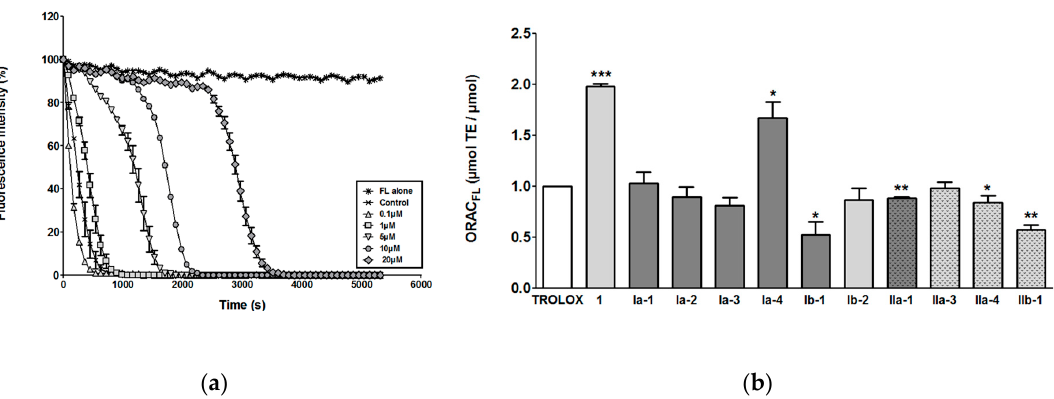
Figure 3. ( a ) Fluorescein (FL) fluorescence decay curve induced by AAPH. Tested compounds (0.1–20 µ M) or trolox standard (1–50 µ M) were pre-incubated with FL (12 nM) in D-PBS (pH 7.4) at 37 °C for at least 30 min. The addition of AAPH reagent (30 mM) led to FL disappearance and the remaining FL fluorescence ( λ Ex : 485 nm; λ Em : 520 nm) was measured every 90 s for 60 cycles. Represented data show results obtained in the absence (control) or the presence of compound IIa-3 at different concentrations and are expressed as means ± SEM of triplicates that form a representative experiment among the at least performed three independent ones and ( b ) oxygen radical absorbance capacity assay using fluorescein (ORAC FL ) values of new HOPO-diamine hybrids, lead compound 1 and references. Bars represent the means ± SEM calculated at 10 µ M of at least three independent experiments performed in triplicate. * p < 0.05; ** p < 0.01; *** p < 0.001 vs. Trolox (Student’s t test: p values < 0.05 were considered significant). Table 3. Reactive carbonyl species (RCS) trapping, oxygen radical absorbance and Cu 2+ ‐ chelating capacities of new HOPO ‐ diamine hybrids in comparison with previous lead compound 1 and references.